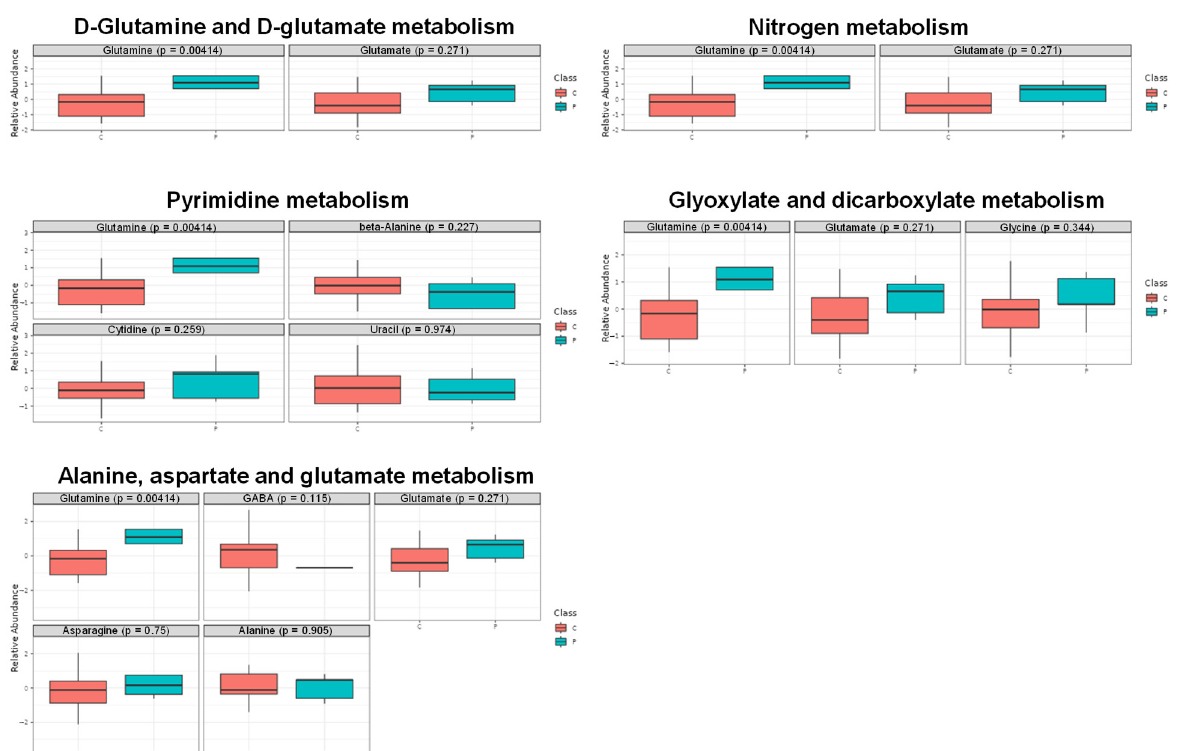
Figure A5. Detailed results of the enrichment analysis in Figure 5a. In each box plot, C and P indicate the data without and with depressive episodes, respectively.